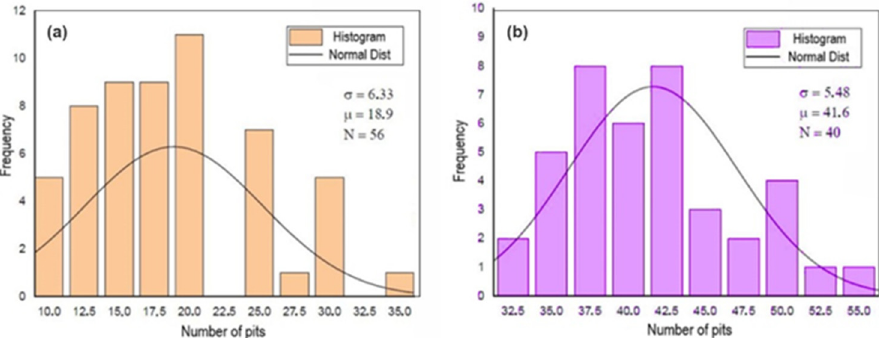
Figure 9. Histogram of the number of pits per analyzed area after the corrosion test for the A0 ( a ) and B0 ( b ) samples. Table 8. Mass loss of the samples submitted to the corrosion test.